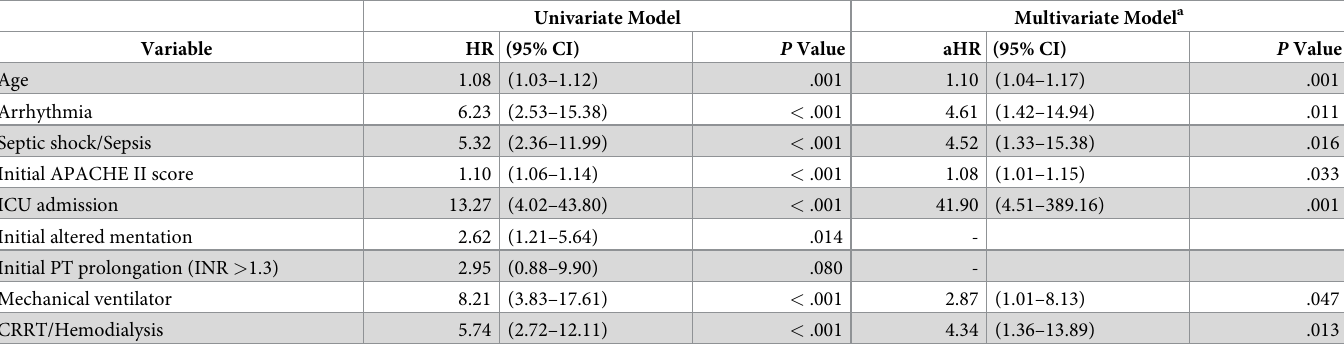
Table 4. Risk Factors Associated with 30-day Mortality in Patients with SFTS.